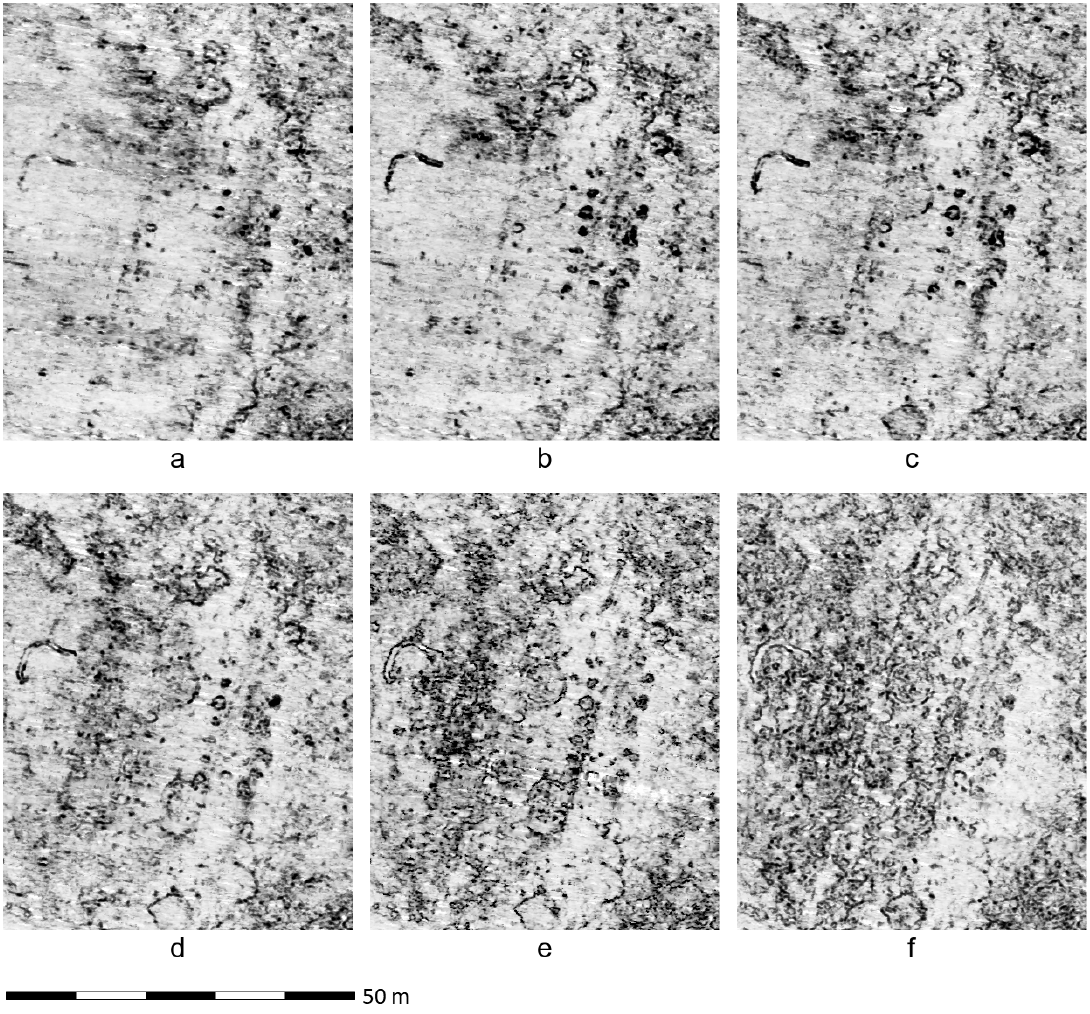
Figure 11. Coherence data after subtraction of the average trace (AT) determined over different distance ranges: ( a ) no AT filter applied, ( b ) with 80 m AT filter, ( c ) with 40 m AT filter, ( d ) with 20 m AT filter, ( e ) with 10 m AT filter, ( f ) with 5 m AT